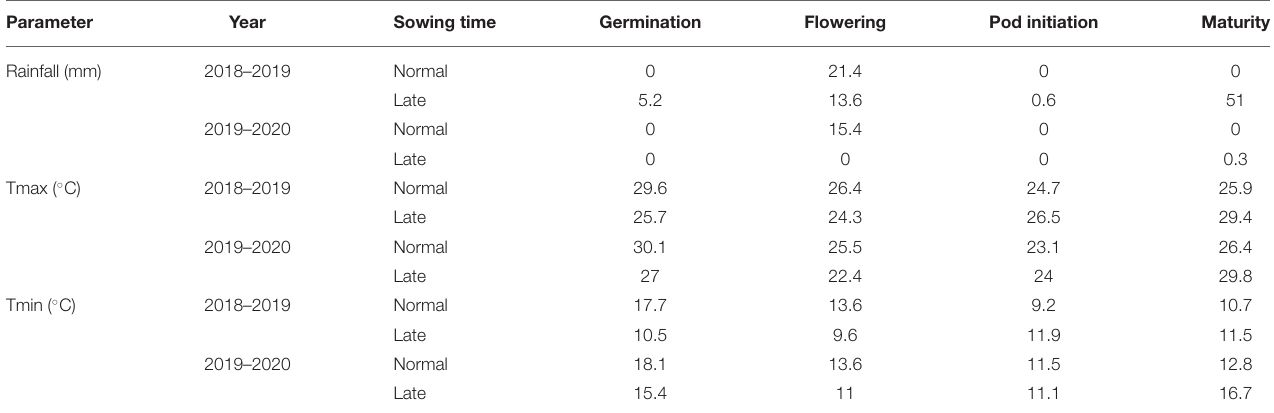
TABLE 2 | Phenological-stage wise mean rainfall, and maximum and minimum temperature during the study period. Parameter Year Sowing time Germination Flowering Pod